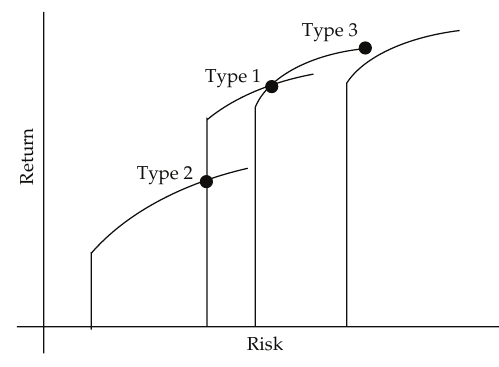
Figure 1: Types of change points.